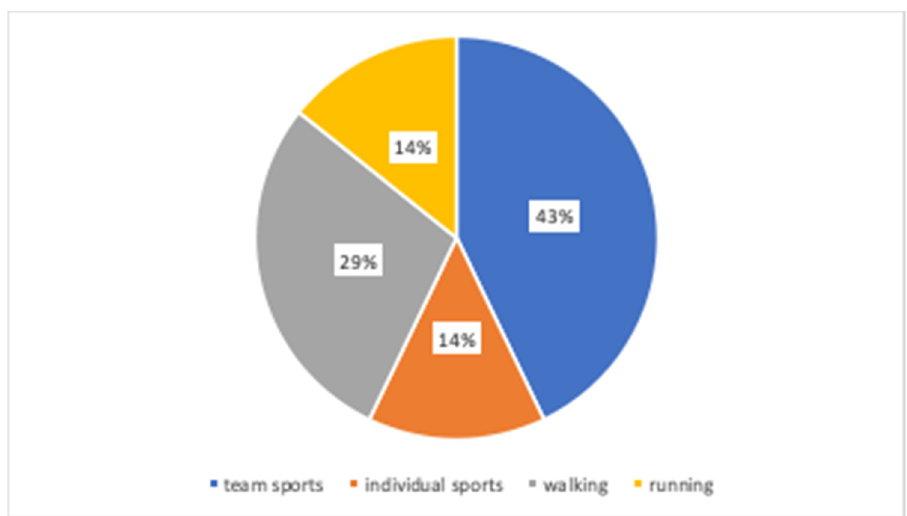
Figure 4. Distribution of students by the preference of physical activities.